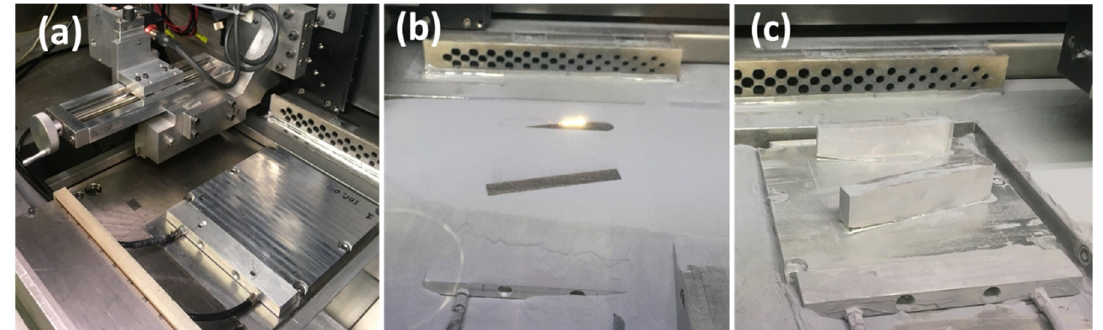
Figure 6. L-PBF printing: ( a ) smart build-plate loaded into open-architecture printer; ( b ) printing of features—parts were buried in spread powder, which limited external inspection; ( c ) removed powder showing delamination events.